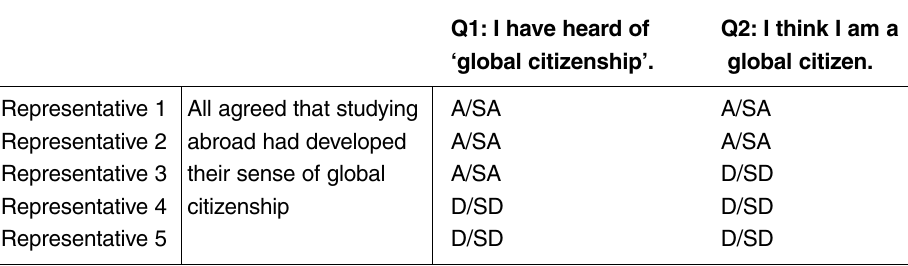
Table 2:The features of the five in-depth interviewees Q1: I have heard of Q2: I think I am a ‘global citizenship’. global